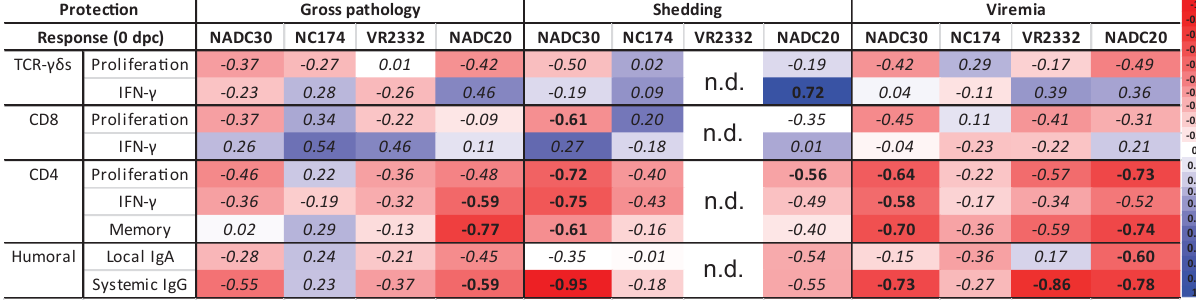
The table lists the R values for the correlations between various immune parameters at 0 dpc (e.g., proliferation, IFN- γ production, and differentiation into CD4 memory cells) and the three protective measures (gross pathology, shedding, and viremia) at 14 dpc. While numbers in italics represent non-significant correlations, the bold numbers emphasize significant correlations( p <